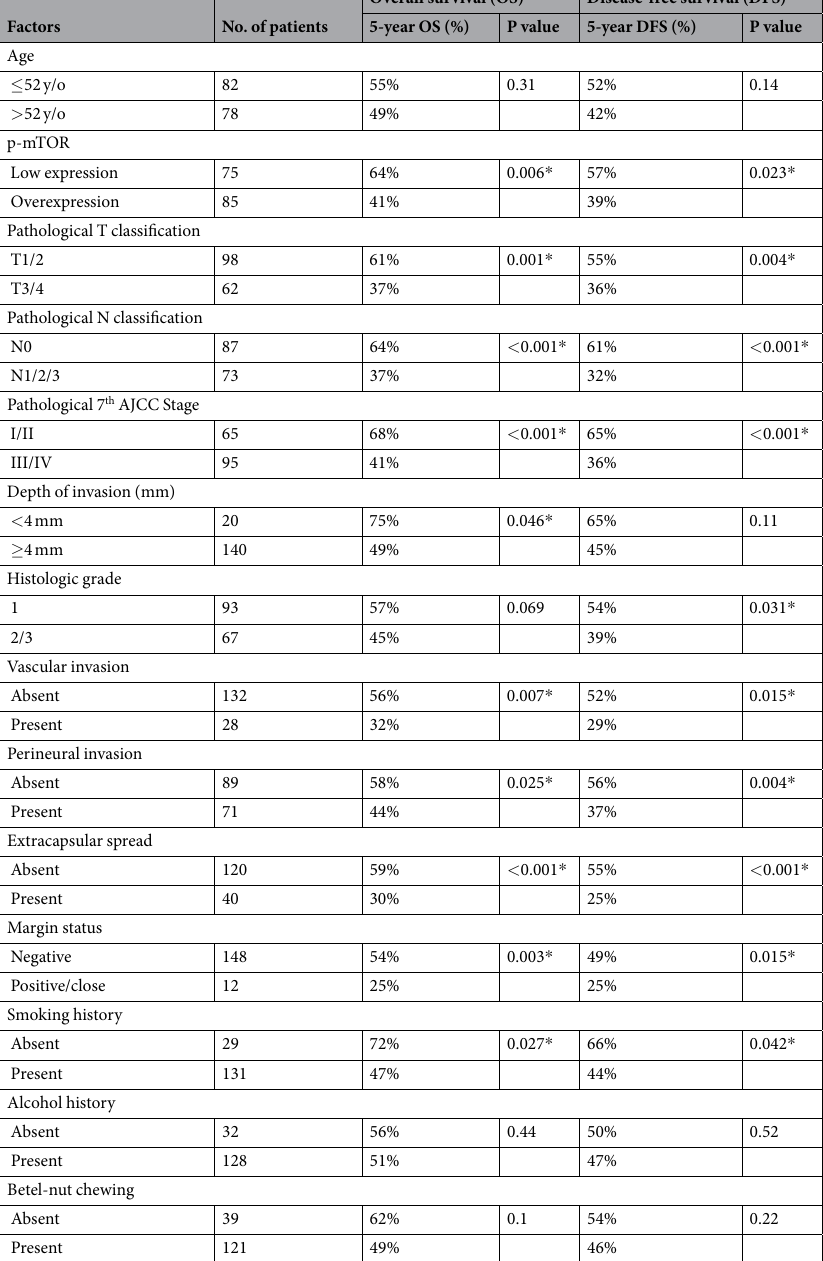
Table 3. Results of univariate log-rank analysis of prognostic factors for overall survival and disease-free survival in 160 patients with tongue squamous cell carcinoma. Abbreviation: p-mTOR, phosphorylated mammalian target of rapamycin; * Statistically